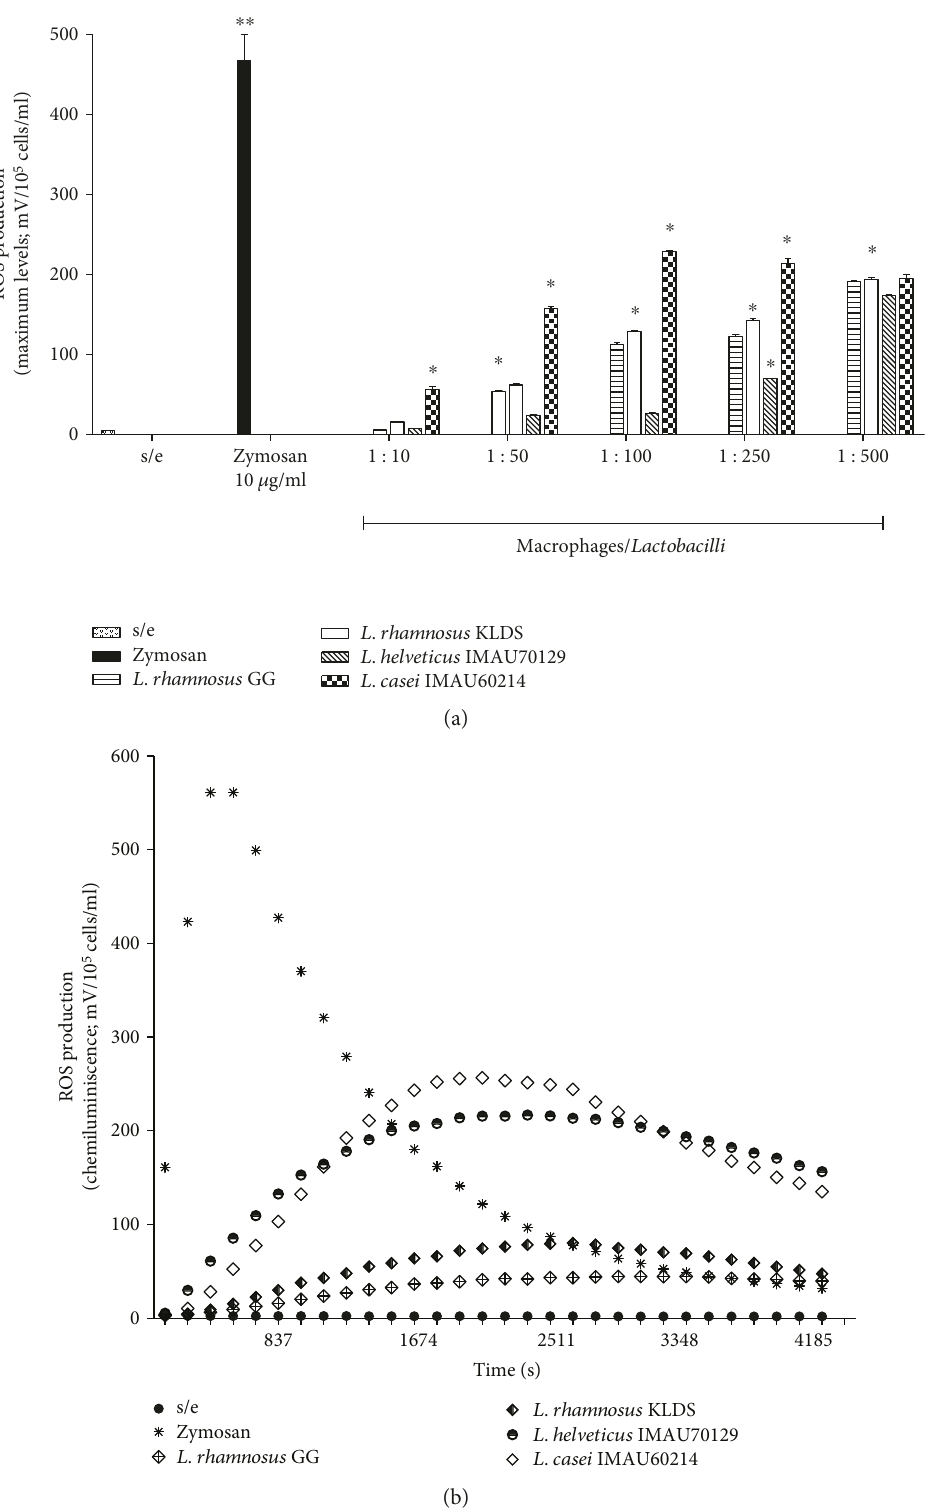
Figure 1: ROS production by human macrophages in response to probiotic heat-killed lactobacillus was measured by luminol-enhanced chemiluminescence. (a) Mixtures were prepared using 1ml of Hank ’ s solution, containing luminol 0.8 × 10 − 4 M, 4 U HRP, and lactobacillus bacteria at di ff erent MOI (1 :1 and 1 :500; bacteria : macrophages). The kinetics of the oxidative response induced in human macrophages by lactobacillus was monitored (b). The values shown represent four experiments that were performed in duplicate. Asterisks indicate the level of statistical signi fi cance between conditions. Signi fi cant di ff erence: p < 0 05